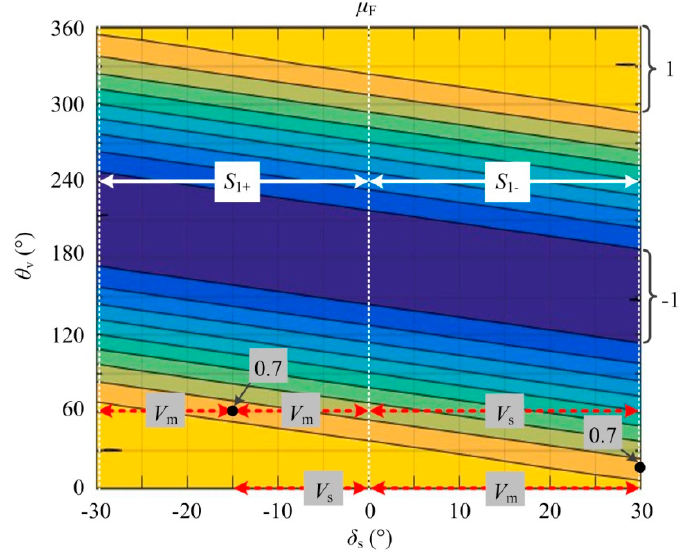
Figure 8. Two-dimensional contour map of flux error active factors.